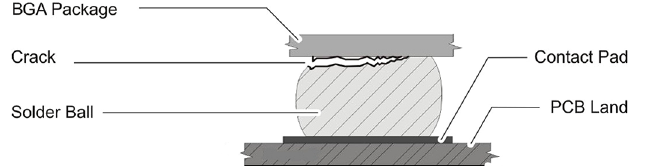
Fig. 2. Image of a solder ball.